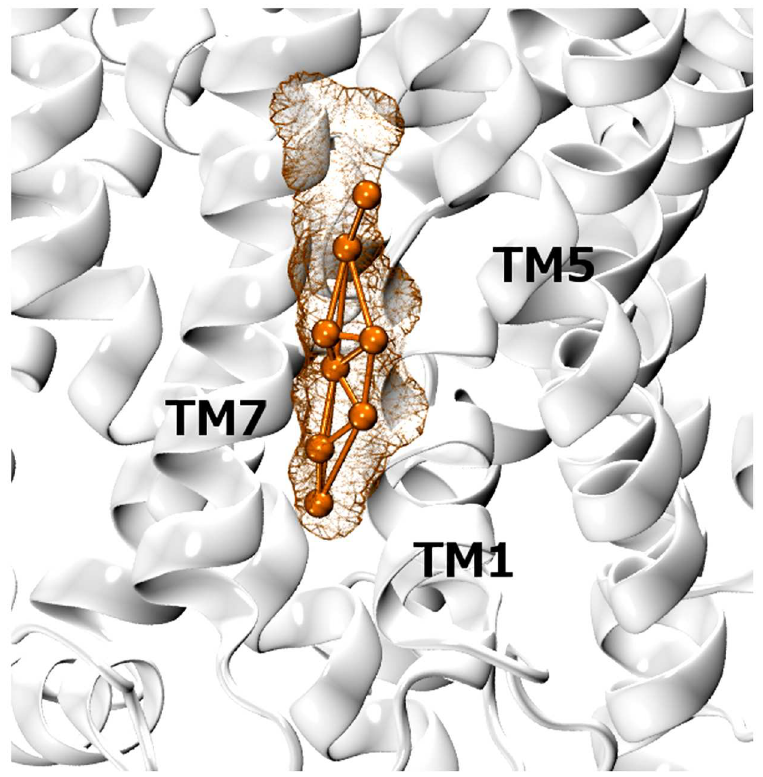
Fig 8. X-ray structure of d DAT (pdb ID: 4M48). Coordinates for the co-crystalized lipid are reportedas orangewired surface and overlap with the alignedpose of a representative cholesterol molecule(orangeCPK representation) emergedfrom simulations(the alignedcoarse-grained h SERT structure in not shown for clarity).